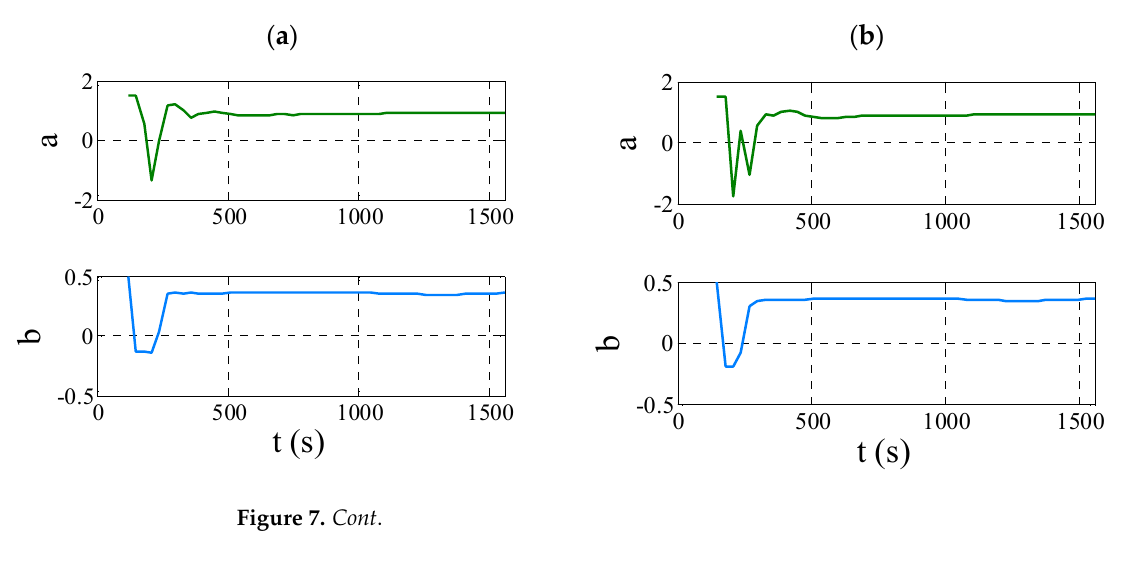
Figure 6. The response of the ash content of the flotation tailings to a step change in the flow rate of the flotation reagent (from a value of 1.5 dm 3 /h to 7.5 dm 3 /h). 1—object output values determined on the basis of identified dynamic models by the method with the use of Kalman filter and 2— measured data for delay times ( a ) 120 s, ( b ) 150 s, ( c ) 210 s, and ( d ) 270 s. In the waveforms of the estimation of the parameters of the dynamic model of Equa- tion (2) shown in Figure 7, one can see, in each case, the moment of the start of the identi- fication process resulting from the delay m (start 1, start 2, ... from Figure 4). One can also see there the determination of the values of the parameters a and b in the dominant ma- jority of cases. This shows that the time of recording and therefore of calculation was suf- ficient.